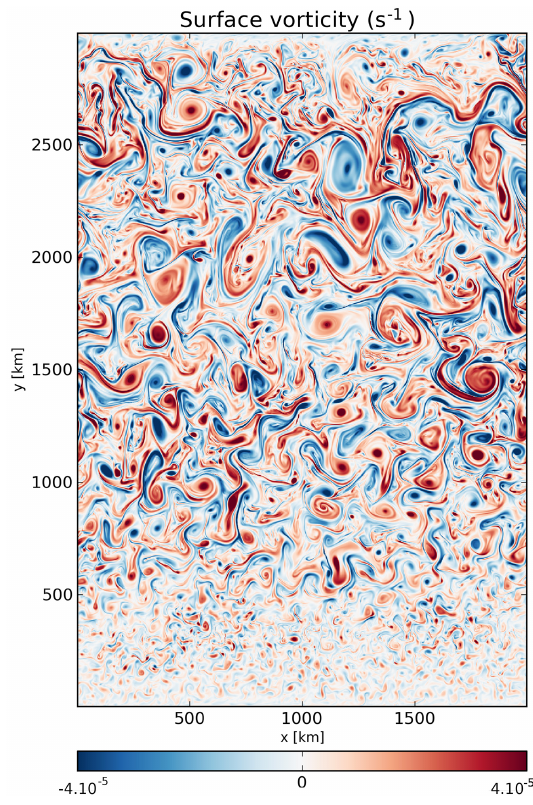
Figure 3. Surface vorticity snapshot (s − 1 ) over the entire model domain at (day) 31 December of year 39 from the 2km horizontal resolution experiment without